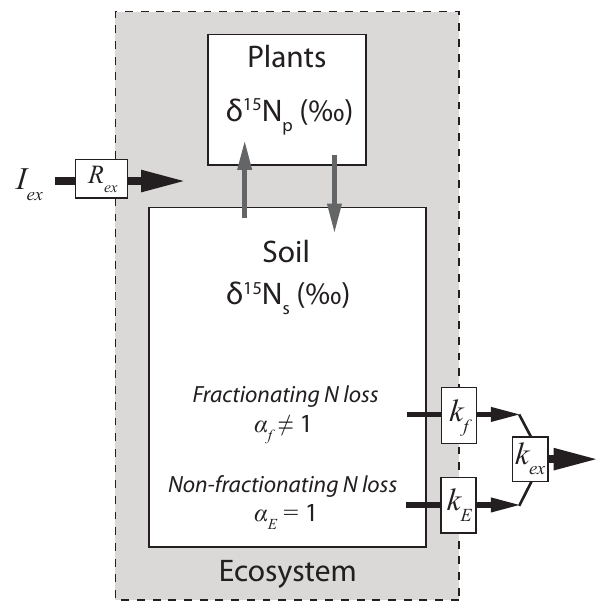
Fig. 1. Controls on the bulk δ 15 N of a forest ecosystem with exter- nal N input and output (black arrows) and internal N cycling (grey arrows). The isotopic ratio of external inputs ( R ex ) delivered at a rate I ex (tNkm − 2 yr − 1 ) are modified by N losses which fraction- ate N isotopes by a factor α f ( 6= 1) by the rate constant k f (yr − 1 ) . N can also be lost by non-fractioning pathways ( α E = 1) which occur at a rate k E (yr − 1 ). The total N loss rate constant, k ex = k f + k E